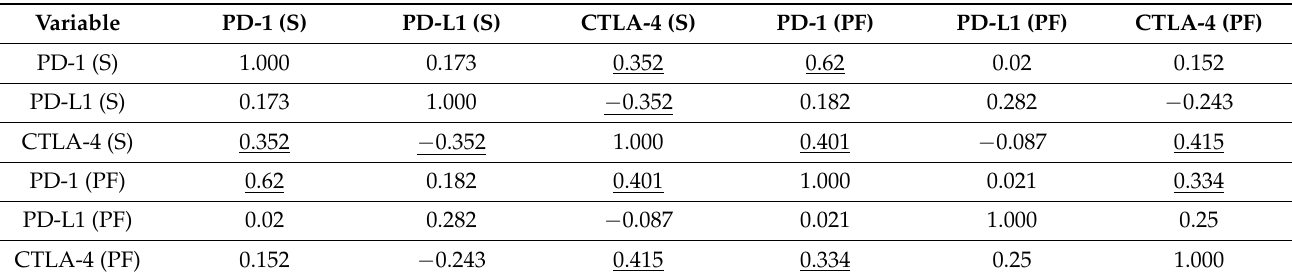
Table 6. The correlations between serum (S) and peritoneal fluid (PF) concentrations of PD-1, PD-L1, and CTLA-4 in OC patients, presented as the Spearman’s ranges‚ r correlation coefficient, p < 0.05 for underlined results.